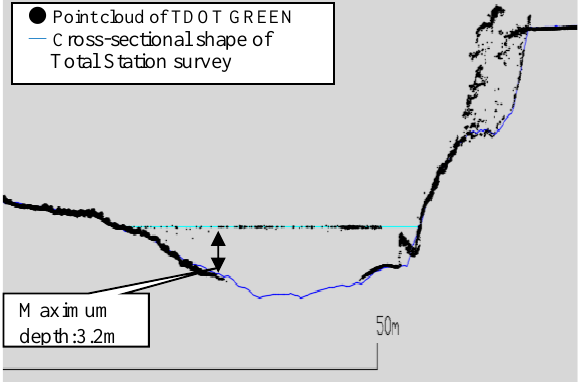
Figure4. Cross-sectional View of Total Station Result and the Point Cloud